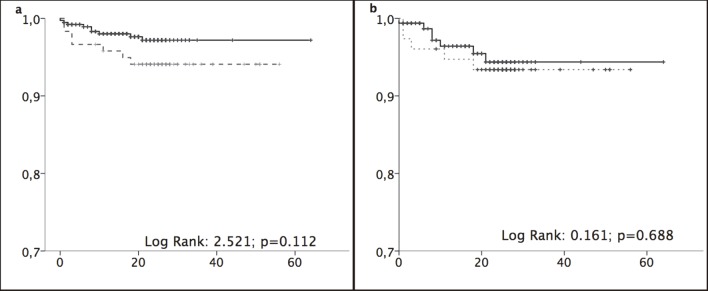
Liver-related events.(a) Liver-related events. (b) Liver-related event in stage F4 patients. Kaplan–Meier curves were compared using log-rank tests between patients aged ≥65 years (black lines) and <65 years (grey dotted lines). Abscissa: time in months. Ordinate: cumulative survival.